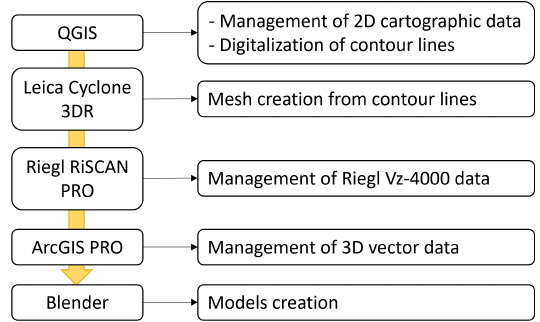
Figure 1. Employed software and implemented workflow for the creation of 3D